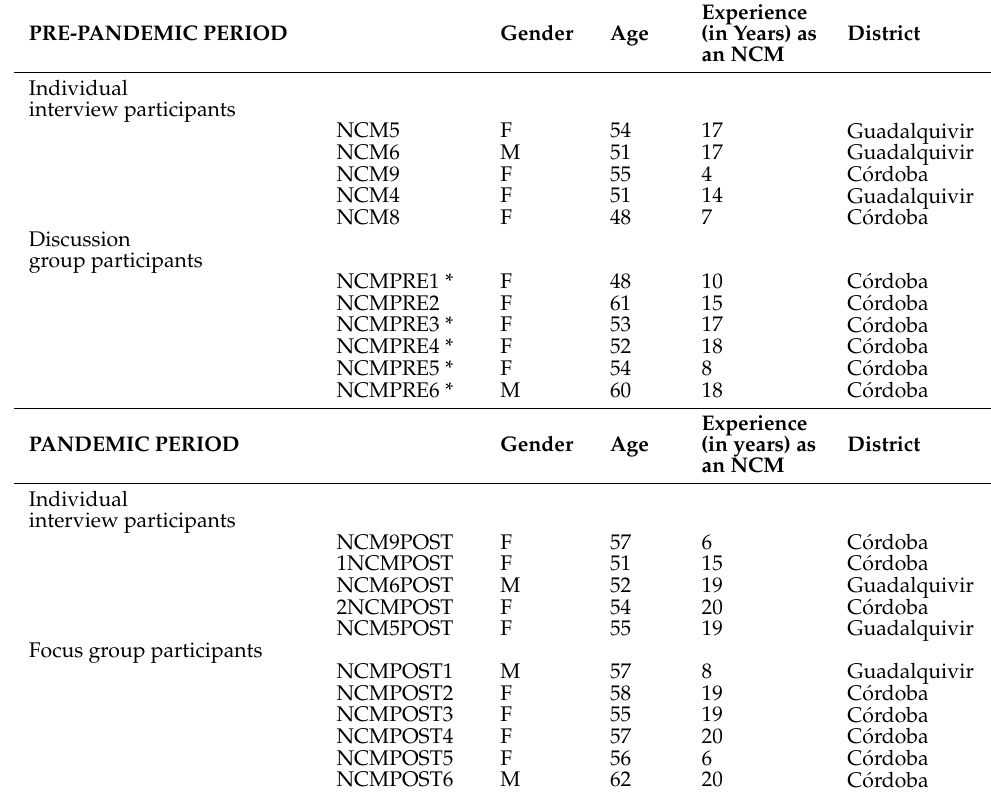
Table 3. Socio-demographic profile of the participating